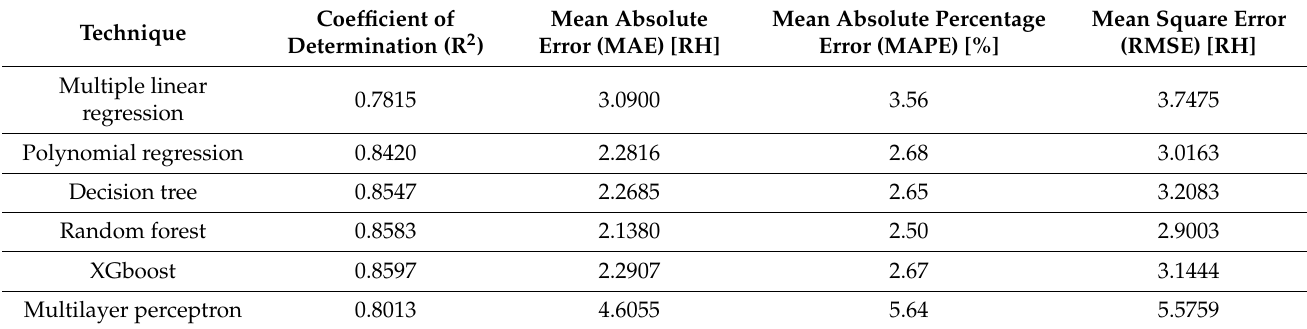
Table 8. Evaluation metrics for relative humidity